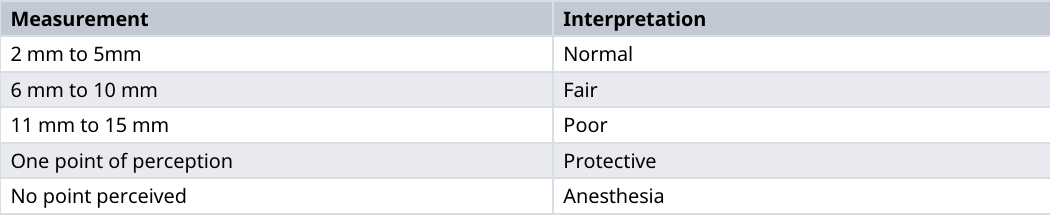
Table 1. Interpretation scale of the two-point discrimination test (reproduced from Silva et al. , 2014).